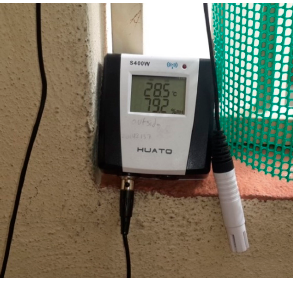
Figure 9. Temperature and humidity wireless data logger .